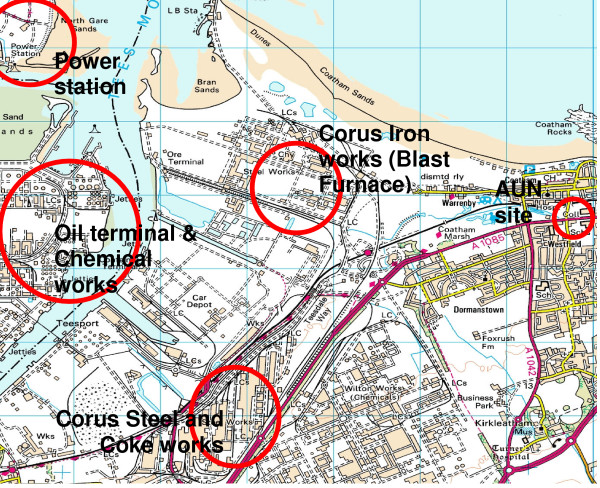
Map of Redcar and surrounding industrial sites. AUN TEOM collection site in proximity to the blast furnace.